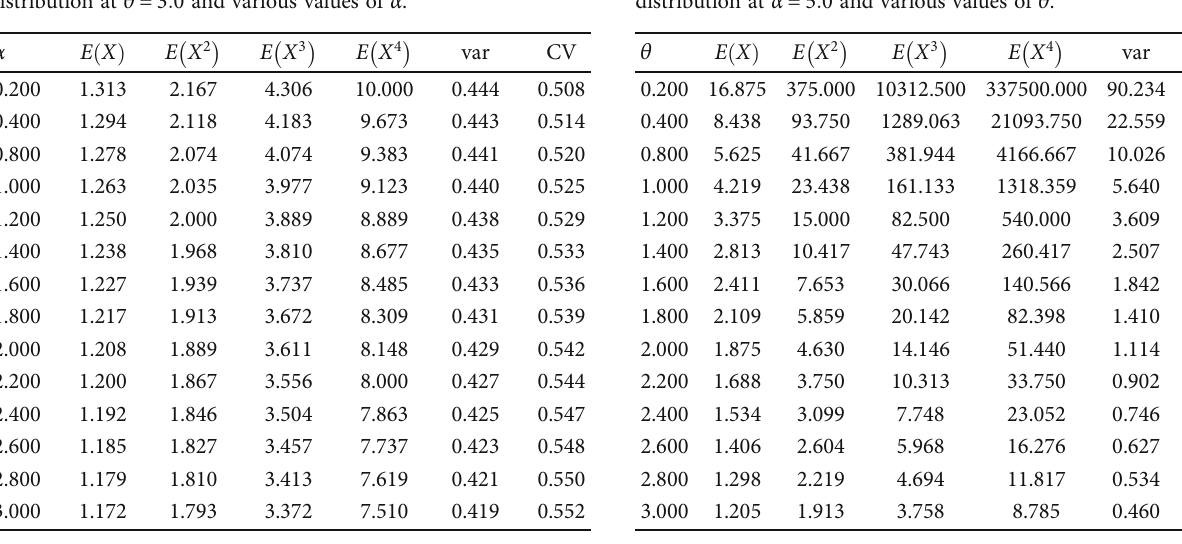
Table 3: Summary statistics of some moments of DWQL distribution at θ = 3 : 0 and various values of α .